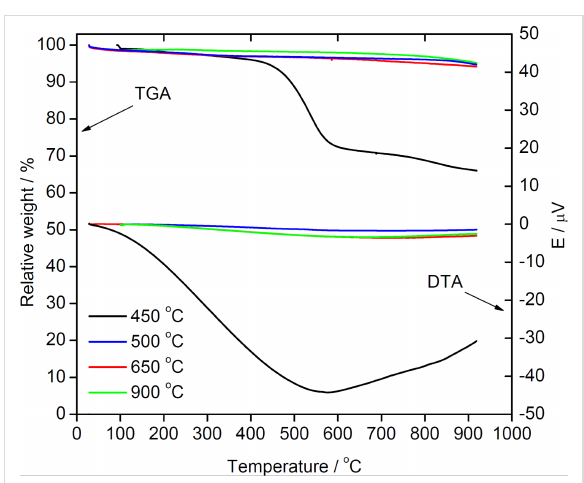
Figure 7: TGA and DTA curves for 2Z-HYCA nanocomposites pre- pared at various temperatures.